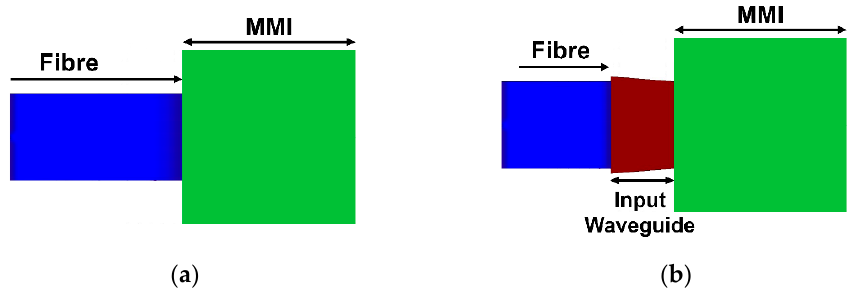
Figure 1. Schematics of the MMI models’ geometries used in BPM simulations: ( a ) MMI coupler with direct fibre attachment; ( b ) MMI coupler with tapered input